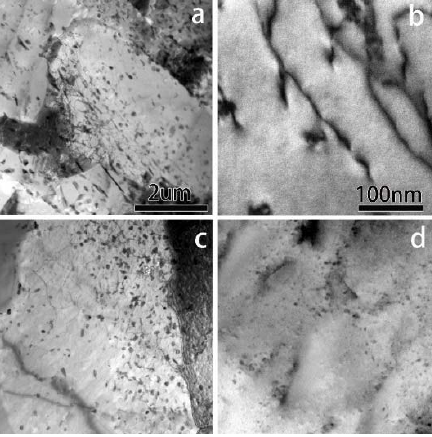
Figure 9. Microstructures in the TMAZ: ( a , b ) on the advancing side; ( c , d ) on the retreating side.